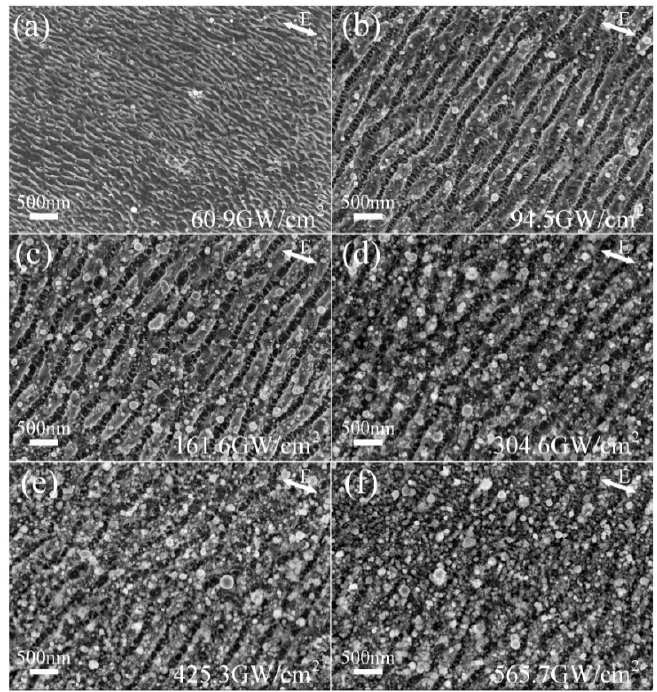
Figure 5. SEM image of the subwavelength ripples induced by different laser peak power density of ( a ) 60.9 GW/cm 2 , ( b ) 94.5 GW/cm 2 , ( c ) 161.6 GW/cm 2 , ( d ) 304.6 GW/cm 2 , ( e ) 425.3 GW/cm 2 and ( f ) 565.7 GW/cm 2 , while the scanning speed is set to 500 mm/s and the line spacing is set to 10 μ m.